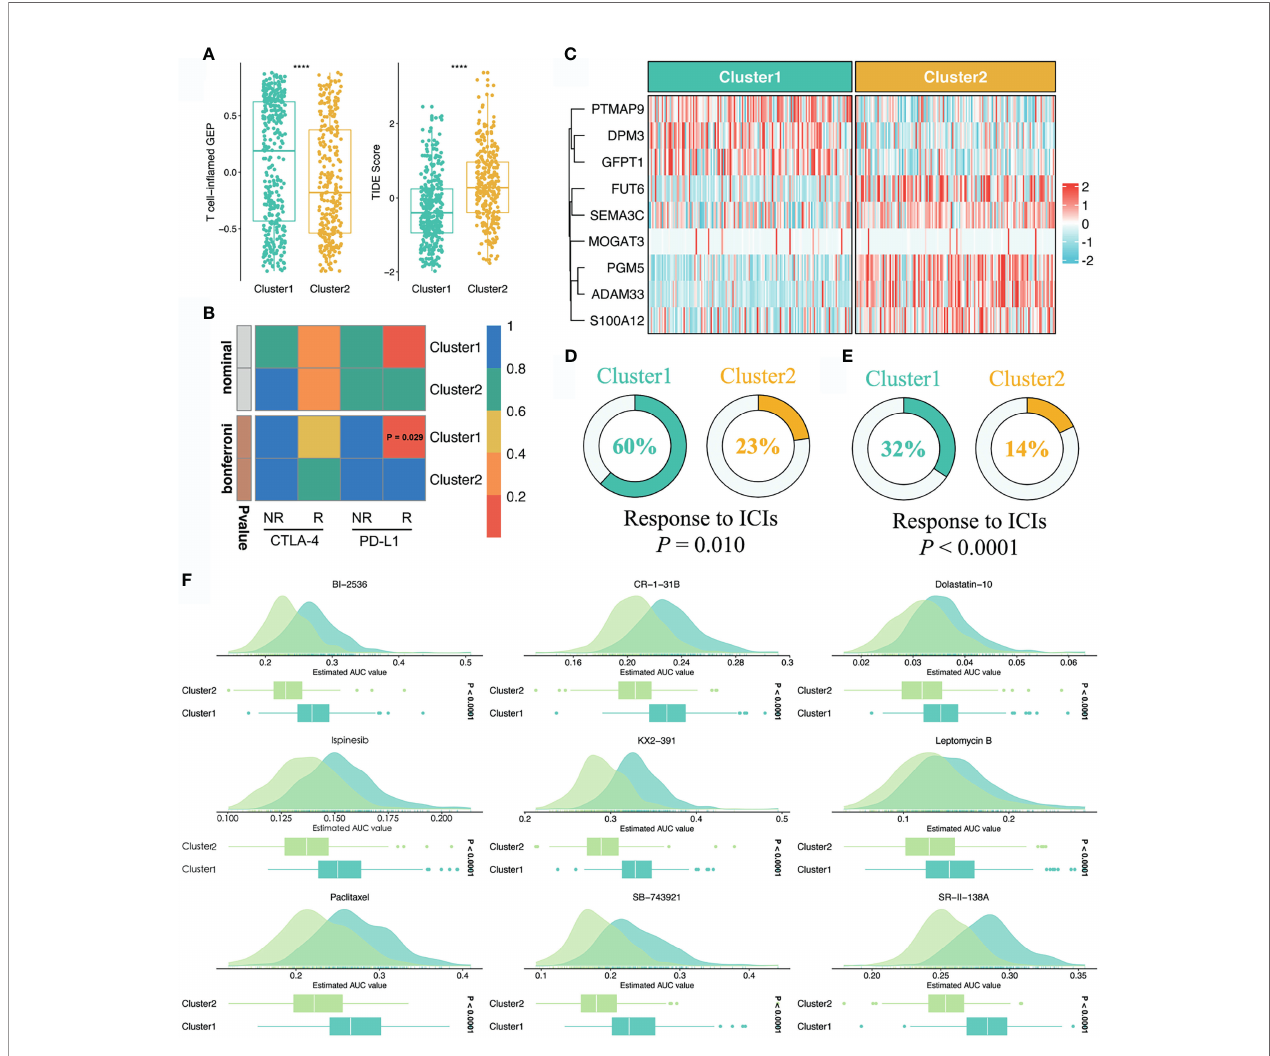
FIGURE 6 | Sensitivity of two clusters to immunotherapy and chemotherapy. (A) Distributions of T-cell-in fl amed GEP and TIDE prediction score between two clusters. **** P < 0.0001. (B) SubMap analysis manifested that the C1 could be more sensitive to the anti-PD-1 therapy (Bonferroni P = 0.029). (C) Using the stemness cluster predictor, CRC patients from IMvigor 210 were categorized into C1 or C2. (D, E) Distributions of responders and nonresponders between two clusters in GSE35640 and IMvigor 210 datasets. (F) Identi fi cation of nine potential therapeutic agents for